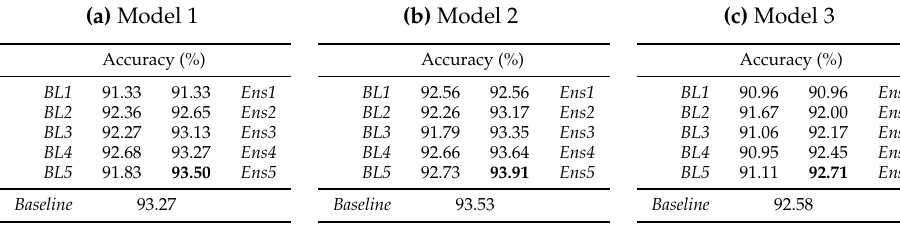
Table 12. Bagging results of baseline models on MNIST-Fashion